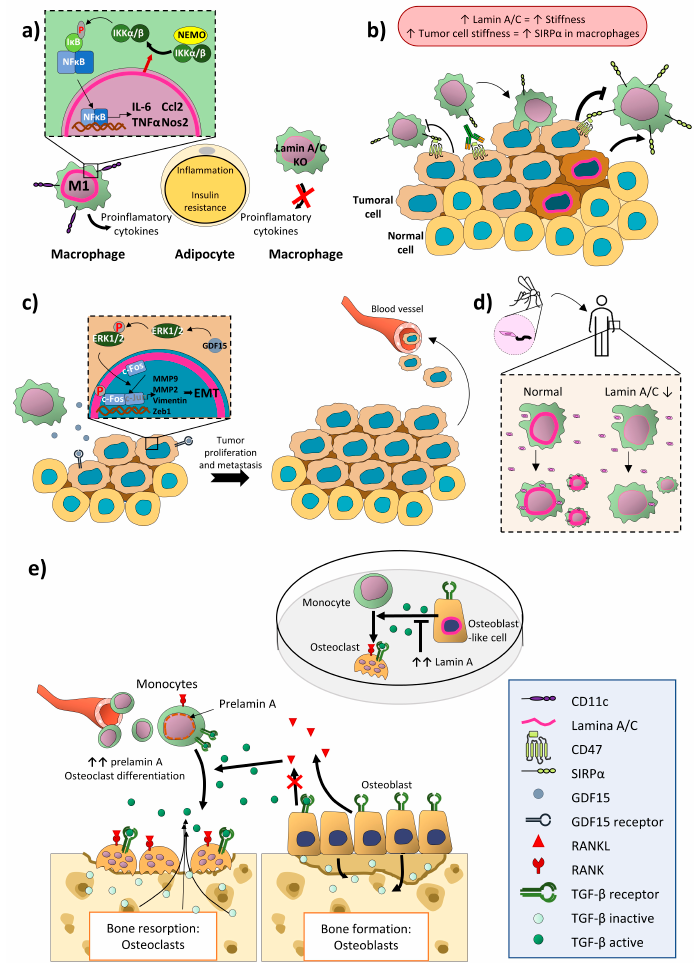
Figure 3. Lamin A / C plays important roles in monocytes and macrophages in pathogen responses, cancer, and obesity. ( a ) Lamin A / C in M1 CD11c + macrophages promotes obesity-induced insulin resistance and reduces adipose tissue inflammation by activating IKK, promoting NF- κ B nuclear translocation, and increasing the expression of proinflammatory genes. ( b ) Expression of CD47 on tumor cells inhibits the action of macrophages by interacting with SIRP α . Lamin A / C content positively correlates with cell sti ff ness, and sti ff ness of solid tumors increases macrophage expression of SIRP α , reducing their phagocytic phenotype. The lamin A / C content of tumor macrophages may serve as an index of SIRP α content, potentially providing a means of predicting the e ffi ciency of CD47- SIRP α checkpoint-directed immunotherapies in some cancer types. ( c ) Tumor macrophages produce GDF15, which in colorectal cancer cells releases c-Fos from inhibition by lamin A / C via ERK1 / 2 phosphorylation, resulting in transcription of AP1-regulated genes and subsequent tumor cell proliferation and metastasis. ( d ) Macrophages are important for resolving infection by Leishmania braziliensis , but can also be infected and serve as a niche for parasite replication. Lower lamin A / C content in macrophages diminishes the prevalence of L. braziliensis in these cells. ( e ) Bone mass remodeling depends on osteoblasts and osteoclasts. TGF β stimulates monocytes to form osteoclasts, which mediate bone resorption, and indirectly limits further osteoclast formation by downregulating the osteoclast di ff erentiation factor RANKL in osteoblasts. TGF β thus regulates bone resorption by first promoting osteoclast di ff erentiation from monocytes and then limiting the extent and duration of resorption. Increased accumulation of the lamin A precursor prelamin A in monocytes induces di ff erentiation towards osteoclasts. In the osteoblast-like cell line U2-OS, Lamin A negatively modulates TGF β 2 release, which may a ff ect monocyte-to-osteoclast di ff erentiation. T arrow, inhibition; red cross, blockade; up arrow, increase; down arrow,